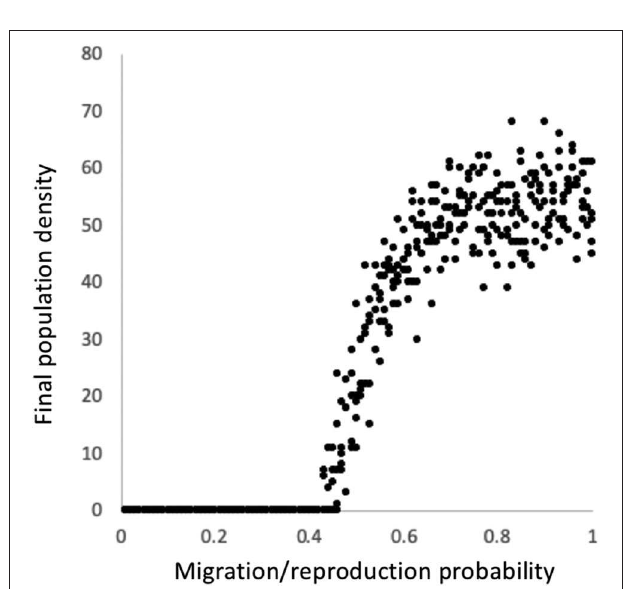
FIGURE 5 | The relationship between the migration coefficient and the final population density (based on a time series of 200 on a space of 100 with random initiation at a probability of 0.5) for the model represented by equation set 4, essentially a stochastic equivalent to Wolfram’s rule